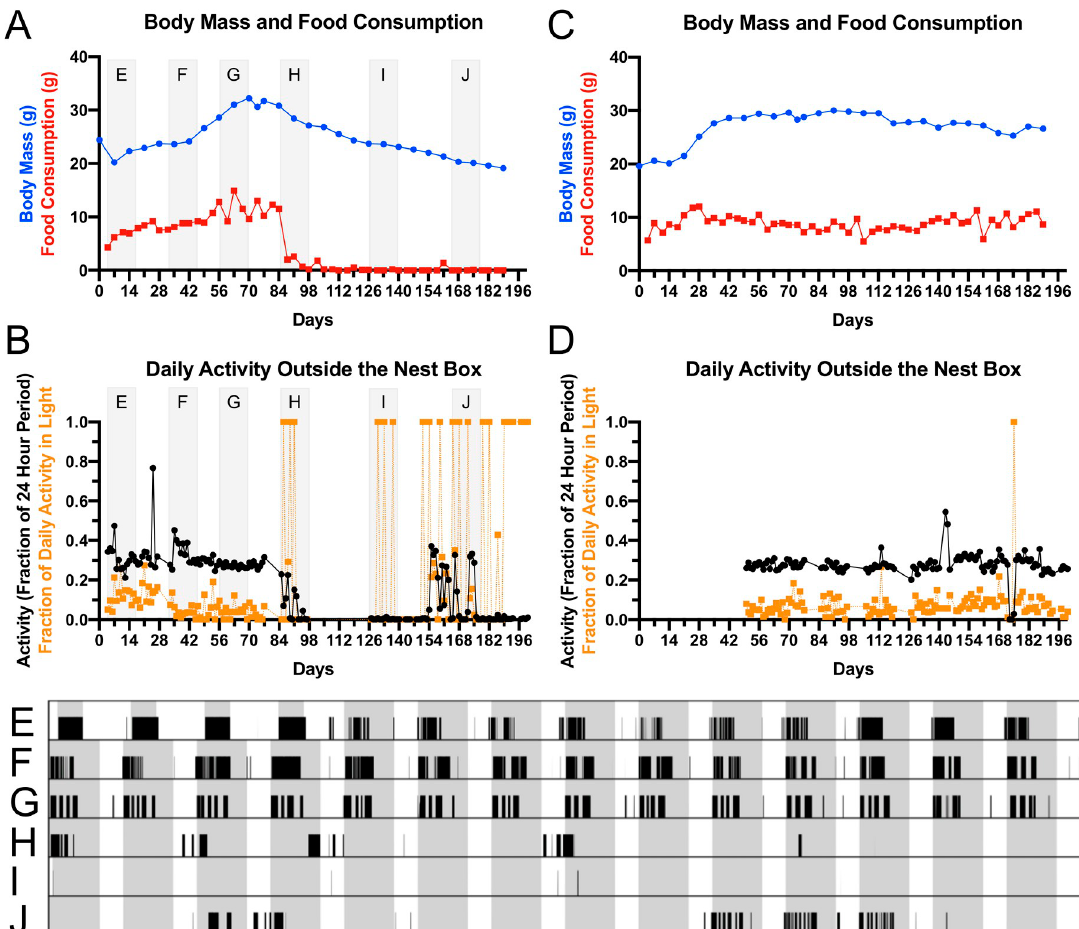
Fig 6. Circadian activity of captive meadow jumping mice before and during hibernation. Body mass (blue lines) and food consumption measurements (red lines) from animals that did ( A ) or did not ( B ) enter torpor at 8L:16D and 7˚ C. For the same animals that did ( C ) and did not ( D ) enter torpor, the total daily activity (fraction of 24 hour period active) is shown with black lines, and the fraction of total activity that occurred during the light phase is show with orange lines. The intervals shaded light gray in panels A and C correspond to the 14-day periods shown in actograms E-J, where the dark phase is shaded gray and activity outside the nest box is represented as black bars. ( E) First 14 days of activity. Hibernation induction conditions began after a 4-day acclimation period. (F,G) Before hibernation, daily activity begins at the onset of the dark phase. ( H ) At the start of hibernation, activity outside the nest box becomes sporadic and no longer aligns with photoperiod. ( I ) Mid-hibernation, essentially no activity occurs outside the nest box. ( J ) Late in hibernation, some activity occurs that either does or does not align with